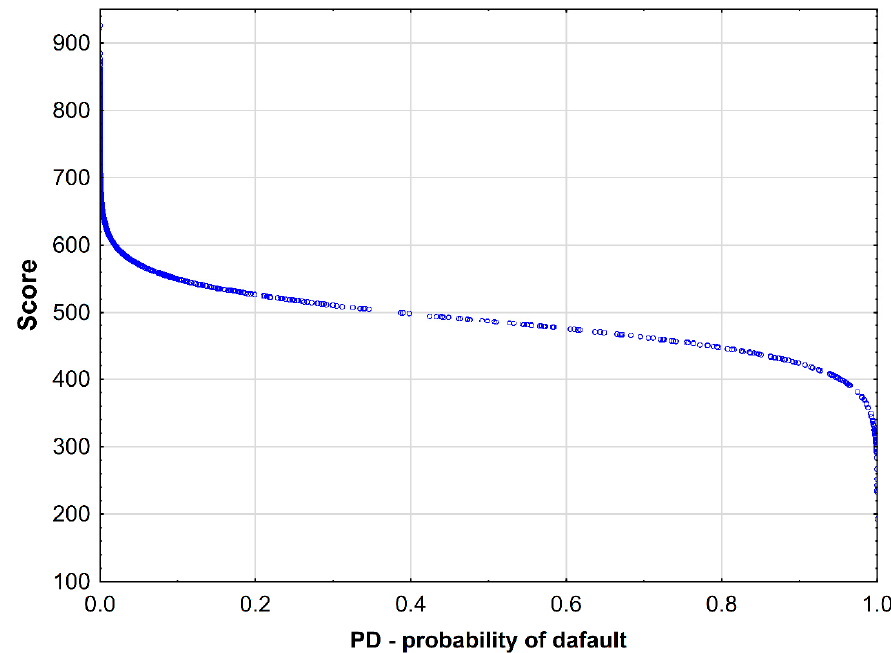
Figure 9. Score scaling in relation to the corresponding probability of default (PD) for the GBM model. Source: own Elaboration using Excel.